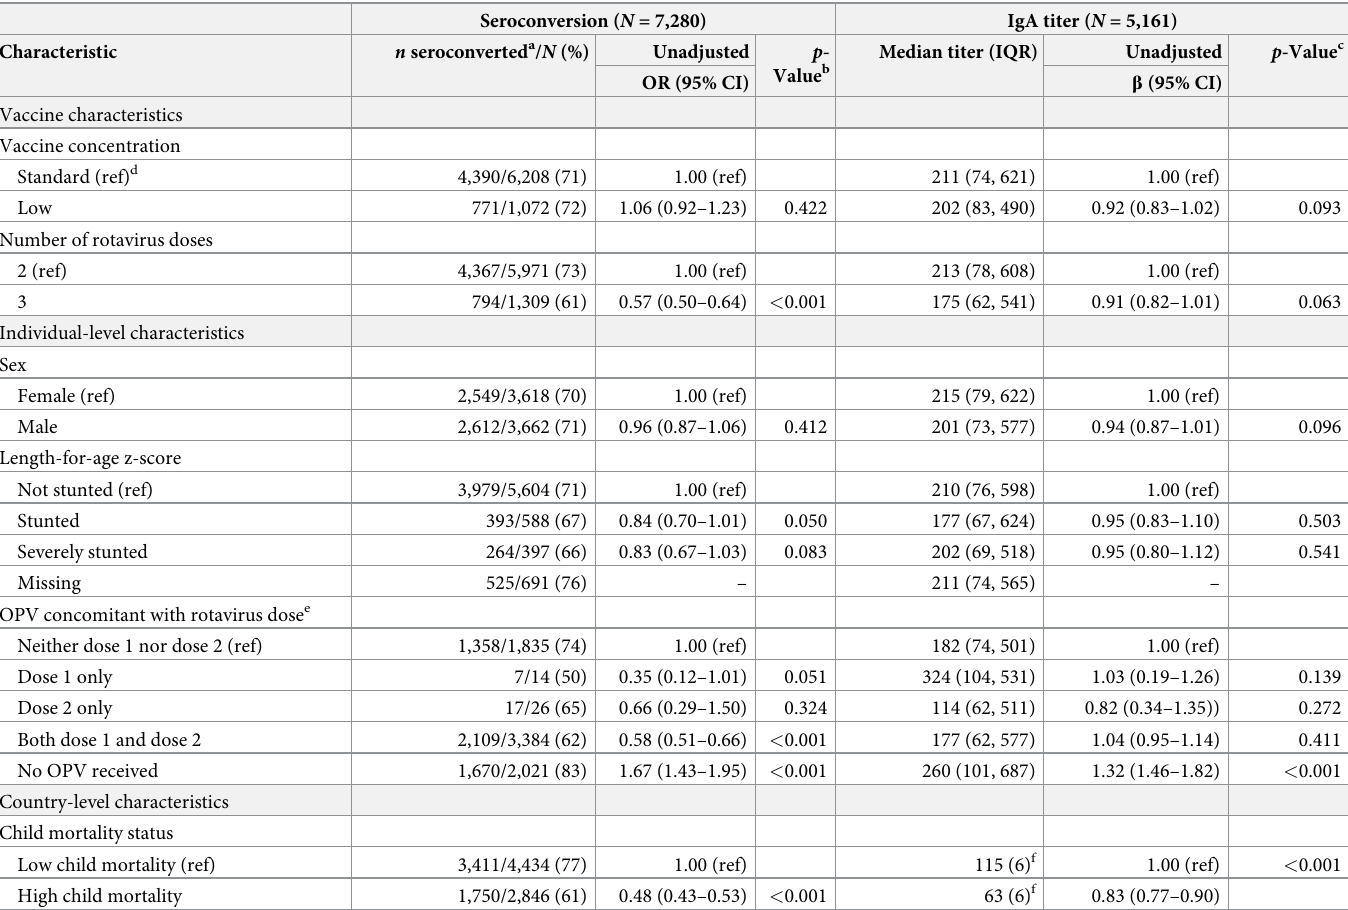
Table 4. Categorical vaccine and individual- and country-level characteristics by antirotavirus IgA seroconversion and antirotavirus IgA titer outcomes. Seroconversion ( N =